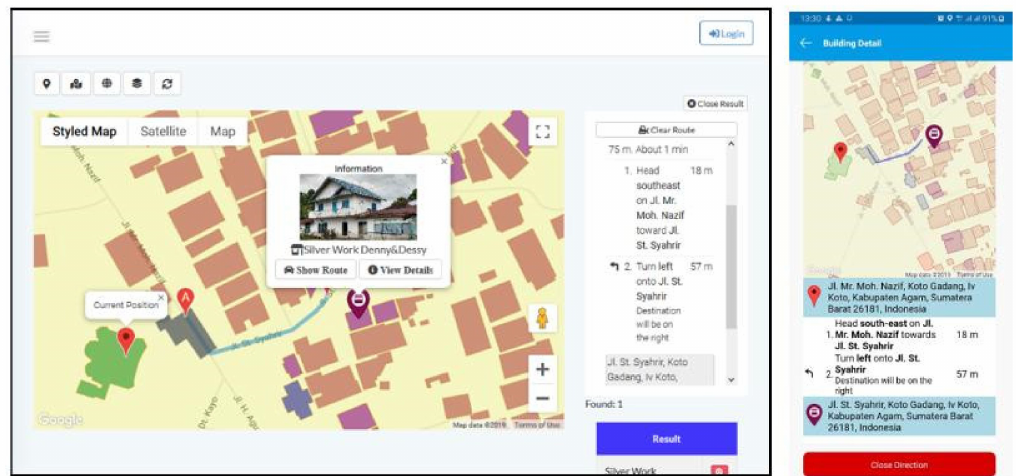
Figure 11. The route to the searched MSME building—Denny and Dessy Silver Work.